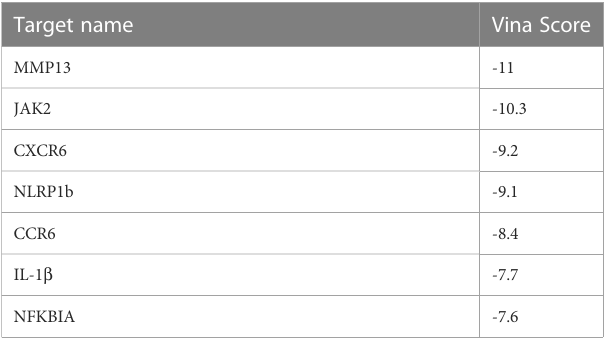
TABLE 1 Molecular docking results of in fl ammatory related C498 drug targets. Target